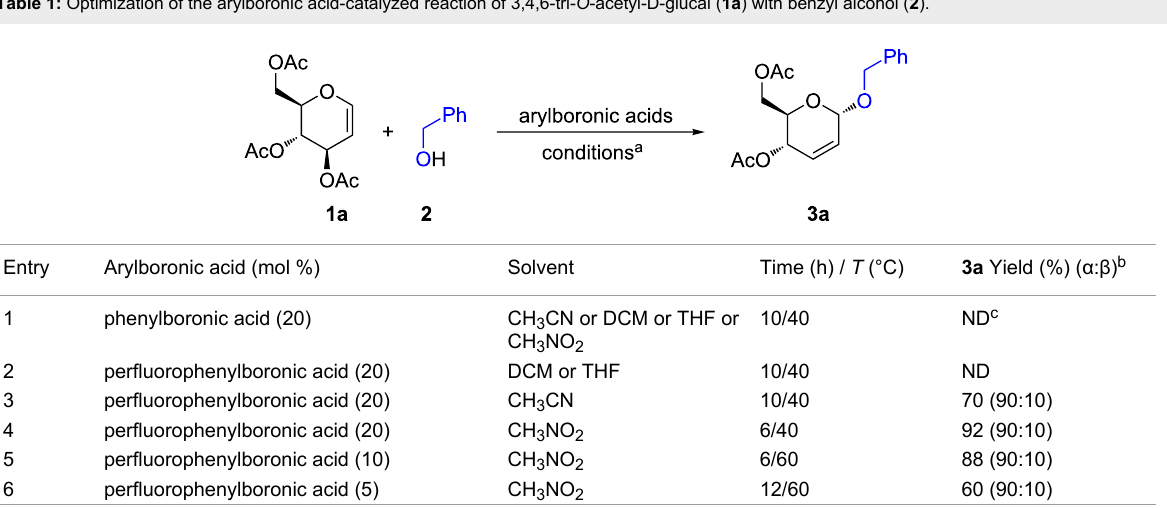
Table 1: Optimization of the arylboronic acid-catalyzed reaction of 3,4,6-tri- O -acetyl-D-glucal ( 1a ) with benzyl alcohol ( 2